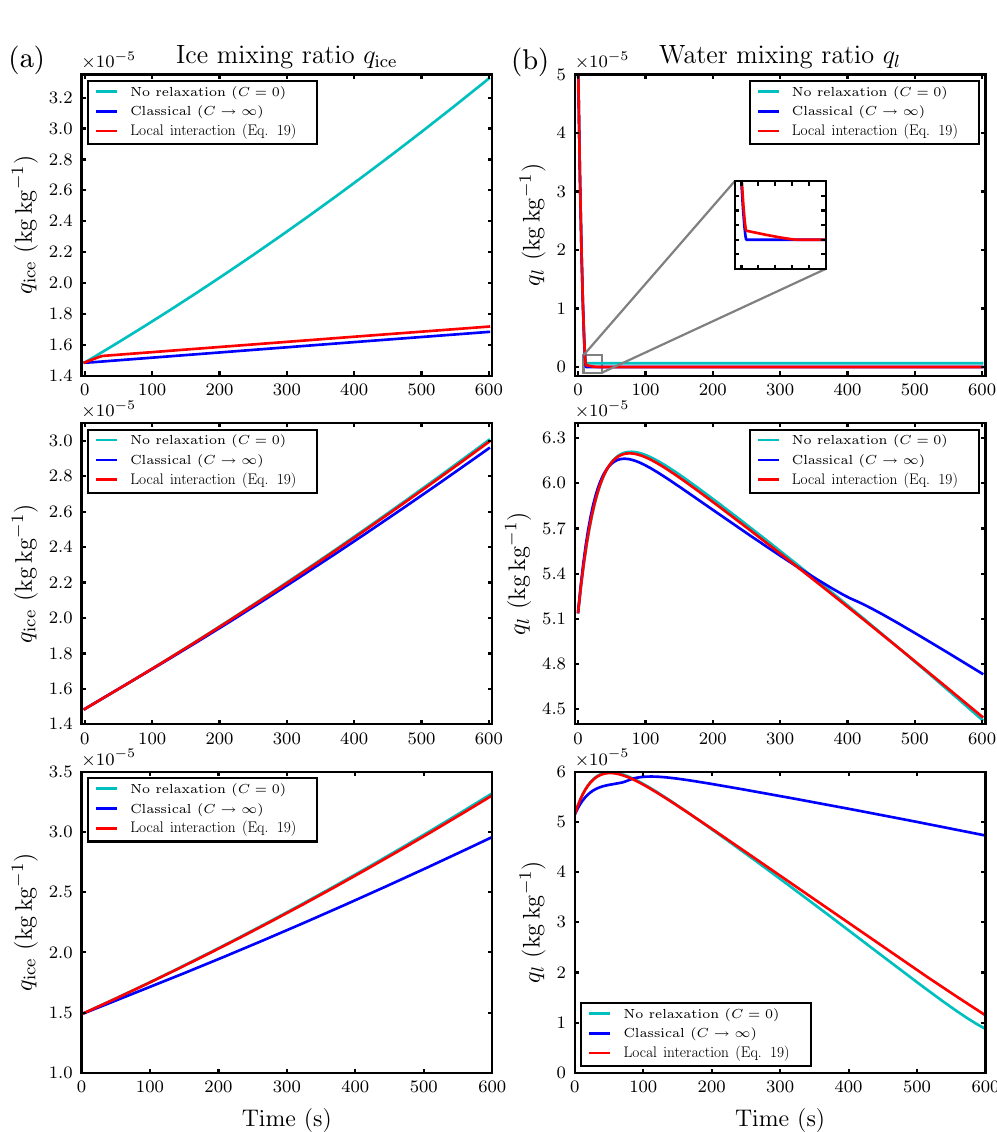
Figure 6. Temporal evolution of ice mixing ratio (a) and liquid water mixing ratio (b) for the parcel model simulations with w = 0ms − 1 . Parameters for the first row are N d = 40 droplets in each influence sphere of the ice crystals at initial ambient saturation ratio S ∞ = 0 . 847 and droplet distance l 0 = 5 R i . The second and third row both have N d = 500 droplets per influence sphere at S ∞ = 1 . 01, while the droplet distance is l 0 = 30 R i for the second row and l 0 = 5 R i for the third row. Note the different scaling of the